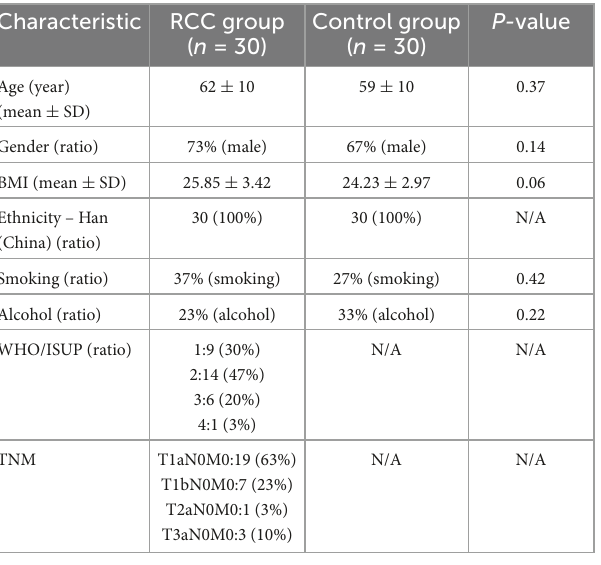
TABLE 1 Baseline characteristics of all